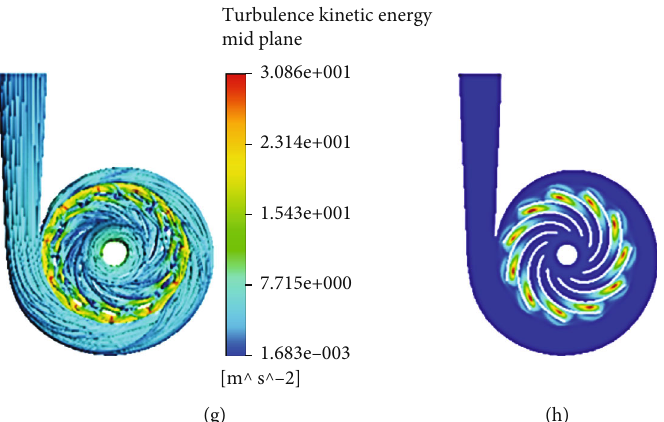
Figure 16: The impact of modi fi cation techniques on pressure distribution, velocity streamline, and turbulence kinetic